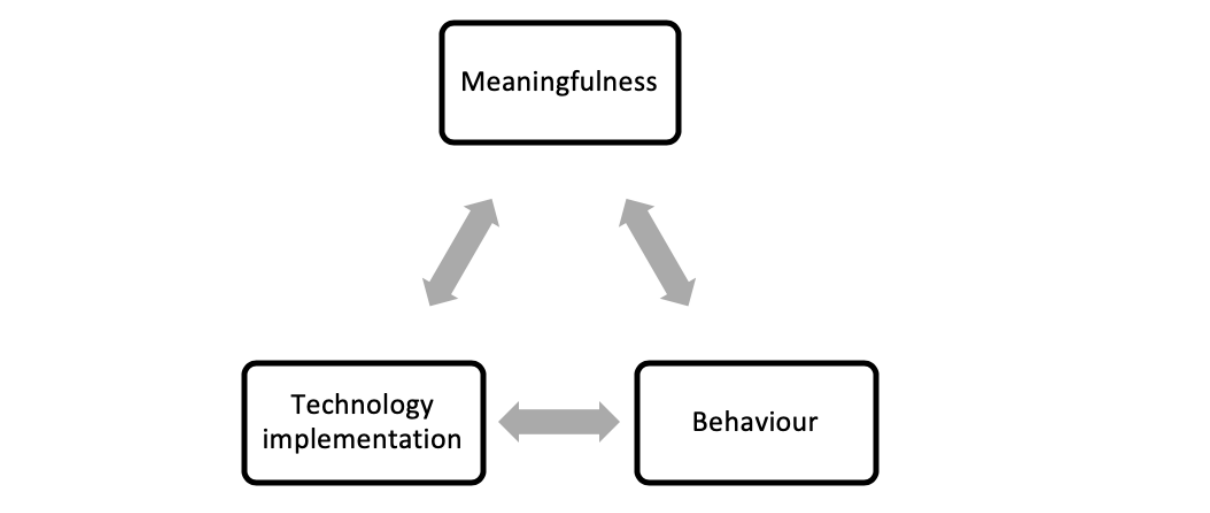
Figure 1. Meaningfulness in digital